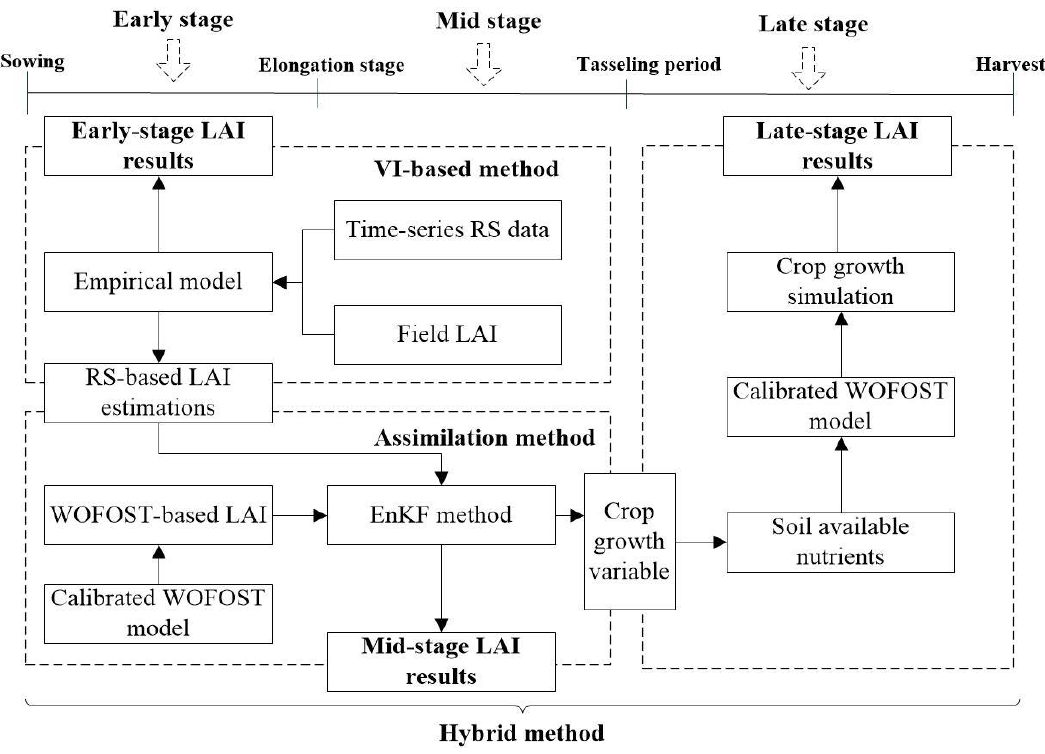
Figure 3. Processes of LAI estimation for the entire growth season using combined methods.